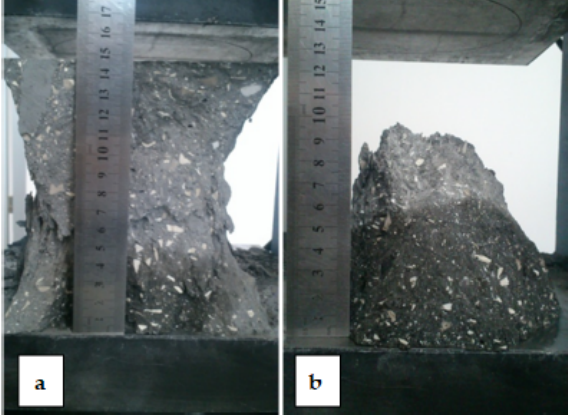
Figure 12. Measuring watertightness SC; a —measuring at the edge, b —measurement in the